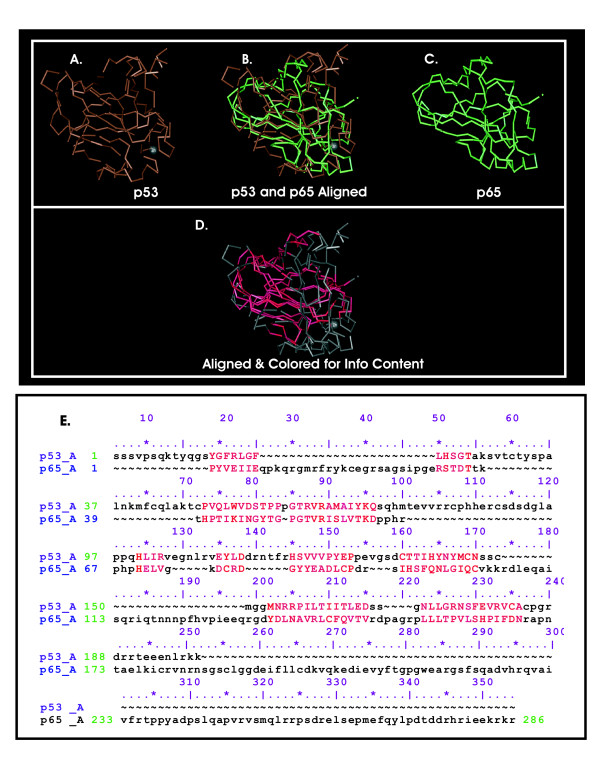
Alignment of p53 (PDB ID:1YCS; 1YCS_A d1) with p65 (PDB ID:1IKN; 1IKN_A d1). A. The structures of p53 molecule (taken from the crystal structure of p53 and p53 binding protein 2); B. The aligned structures of p53 and p65; C. The structure of the Rel homology domain of p65 (taken from the crystal structure of the p65/p50 heterodimer bound to IκBα); D. The aligned structures were colored according to information content based on a BLOSUM62 matrix to calculate conservation using the public domain program CN3D4.1 [70]. A spectrum of red to blue is used to denote the degree of conservation where red is the most conserved. E. The sequence alignment of p53 and p65 is depicted using the same coloring scheme as in the structure alignment in 1D.